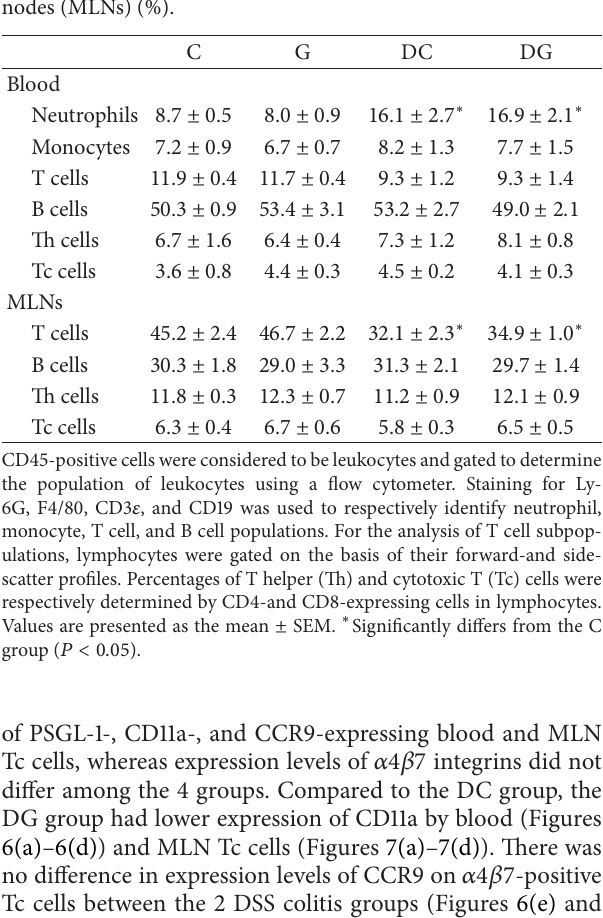
Table 2: Leukocyte populations in blood and mesenteric lymph nodes (MLNs) (%).